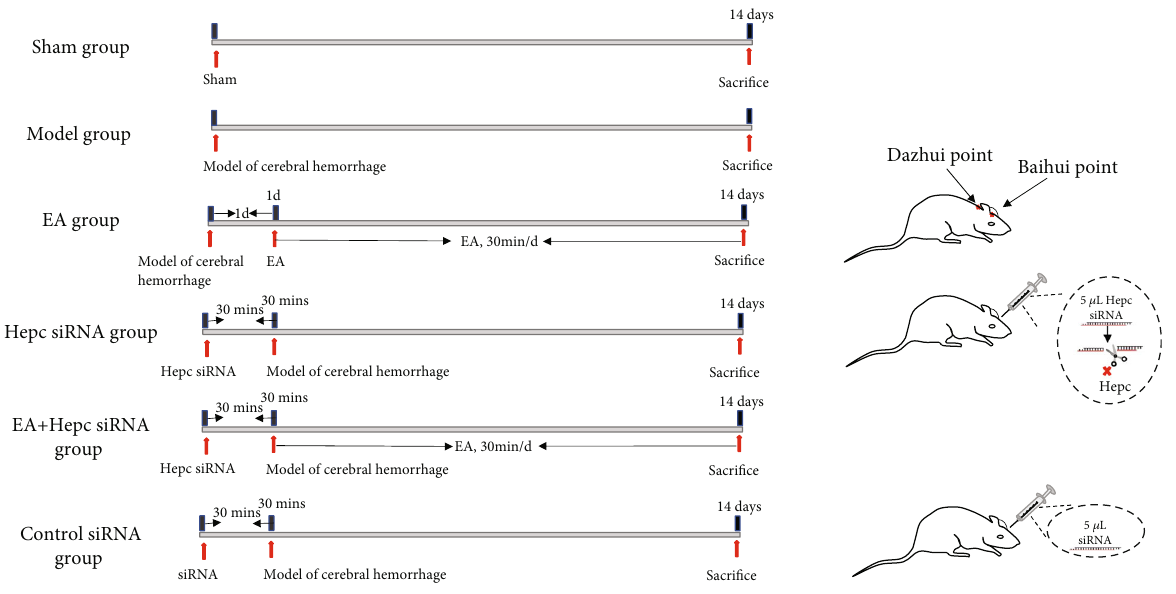
Figure 1: Grouping and intervention